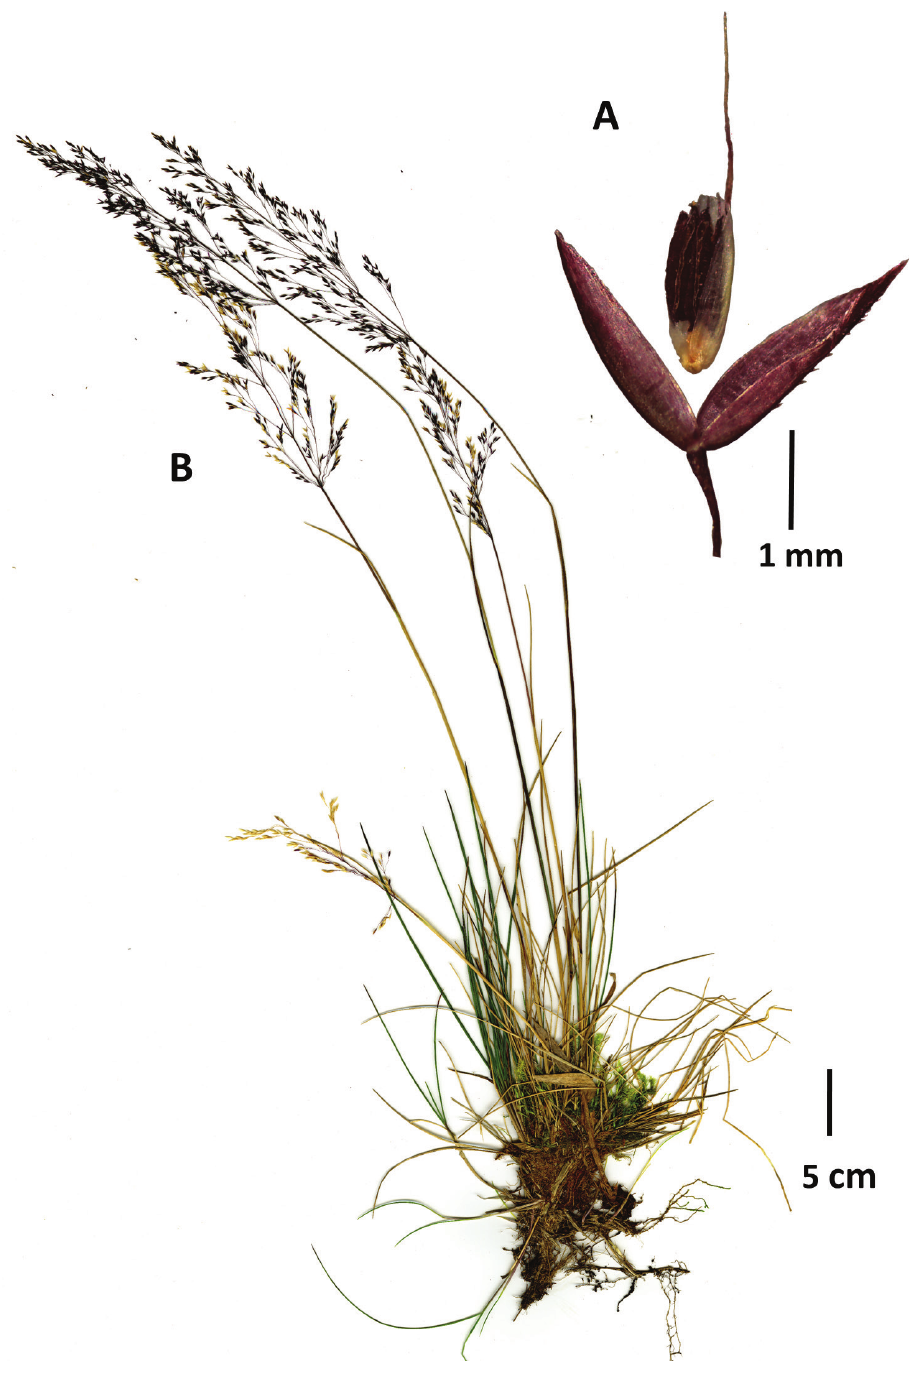
Figure 7. Agrostis mertensii A spikelet, lateral view, with floret detached and raised above the glumes B whole plant. Images of Cuta-Alarcon 365